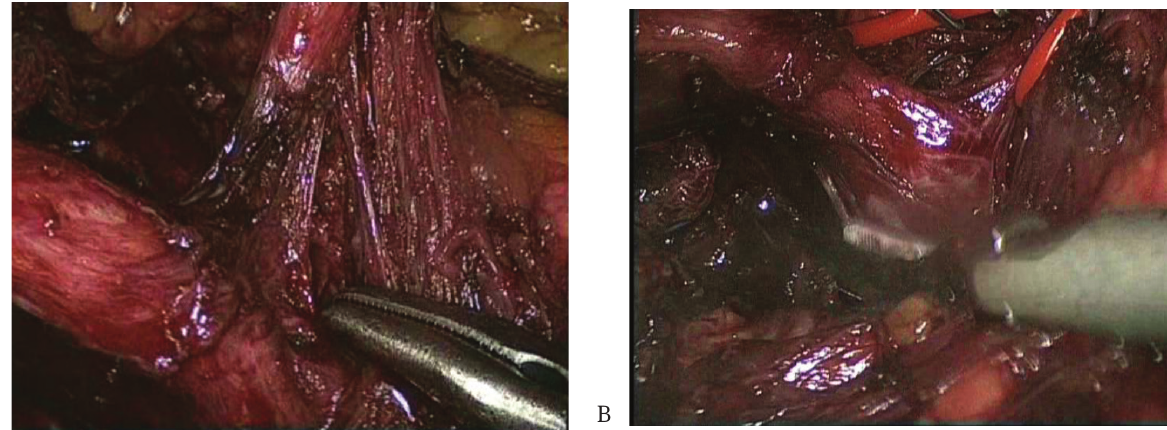
A B Figure 3 a-b: Dissection of fibro-adipose tissue of the origin of the celiac trunk